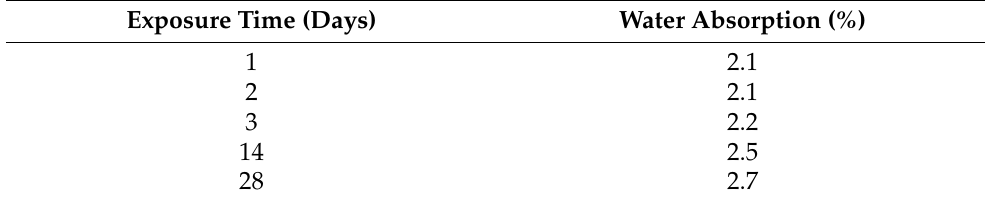
Table 1. Foam water absorption as a function of time at atmospheric